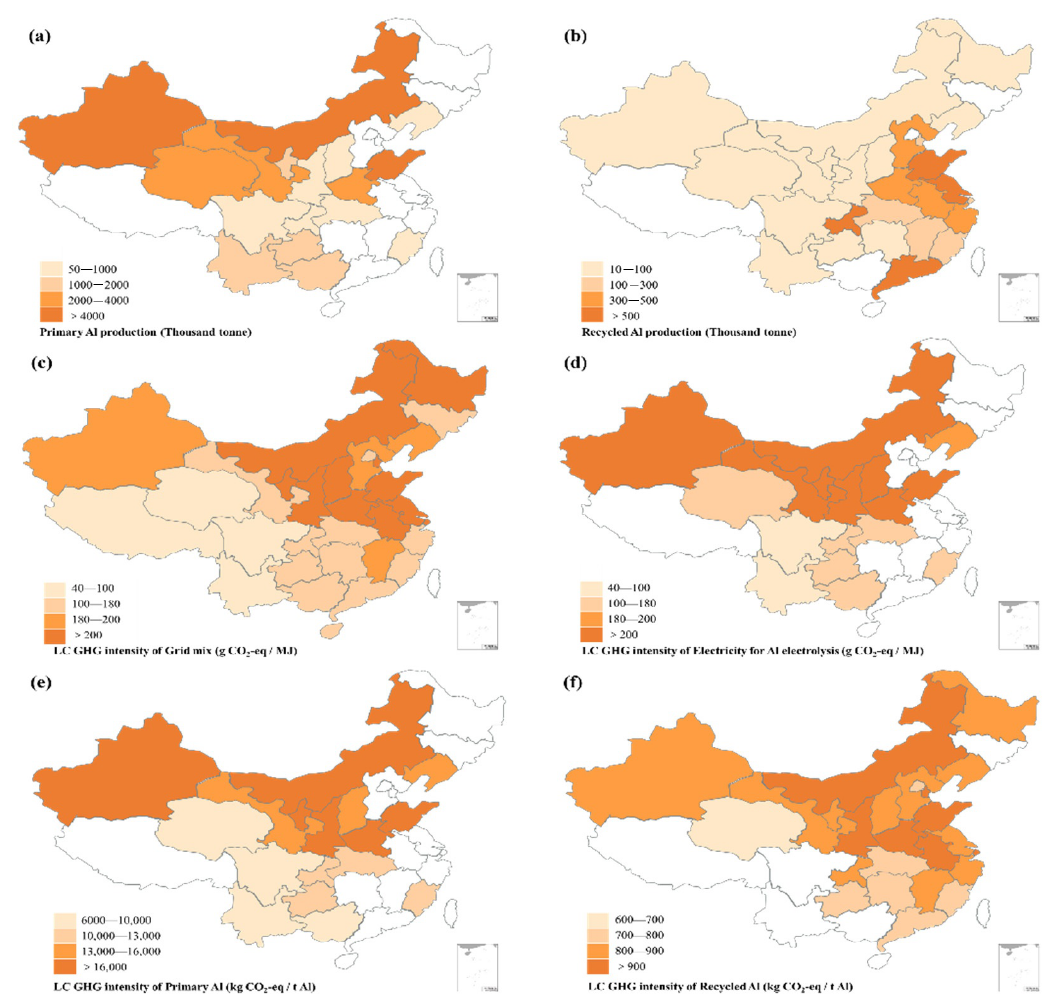
Figure 4. Provincial aluminum industry data in mainland China: ( a ) Primary aluminum and ( b ) recycled aluminum production in 2019; ( c ) LC GHG emissions intensity of the grid mix; ( d ) LC GHG emissions intensity of electricity for aluminum electrolysis; ( e ) GHG emissions intensity of primary aluminum; and ( f ) GHG emissions intensity of recycled aluminum in 2020.